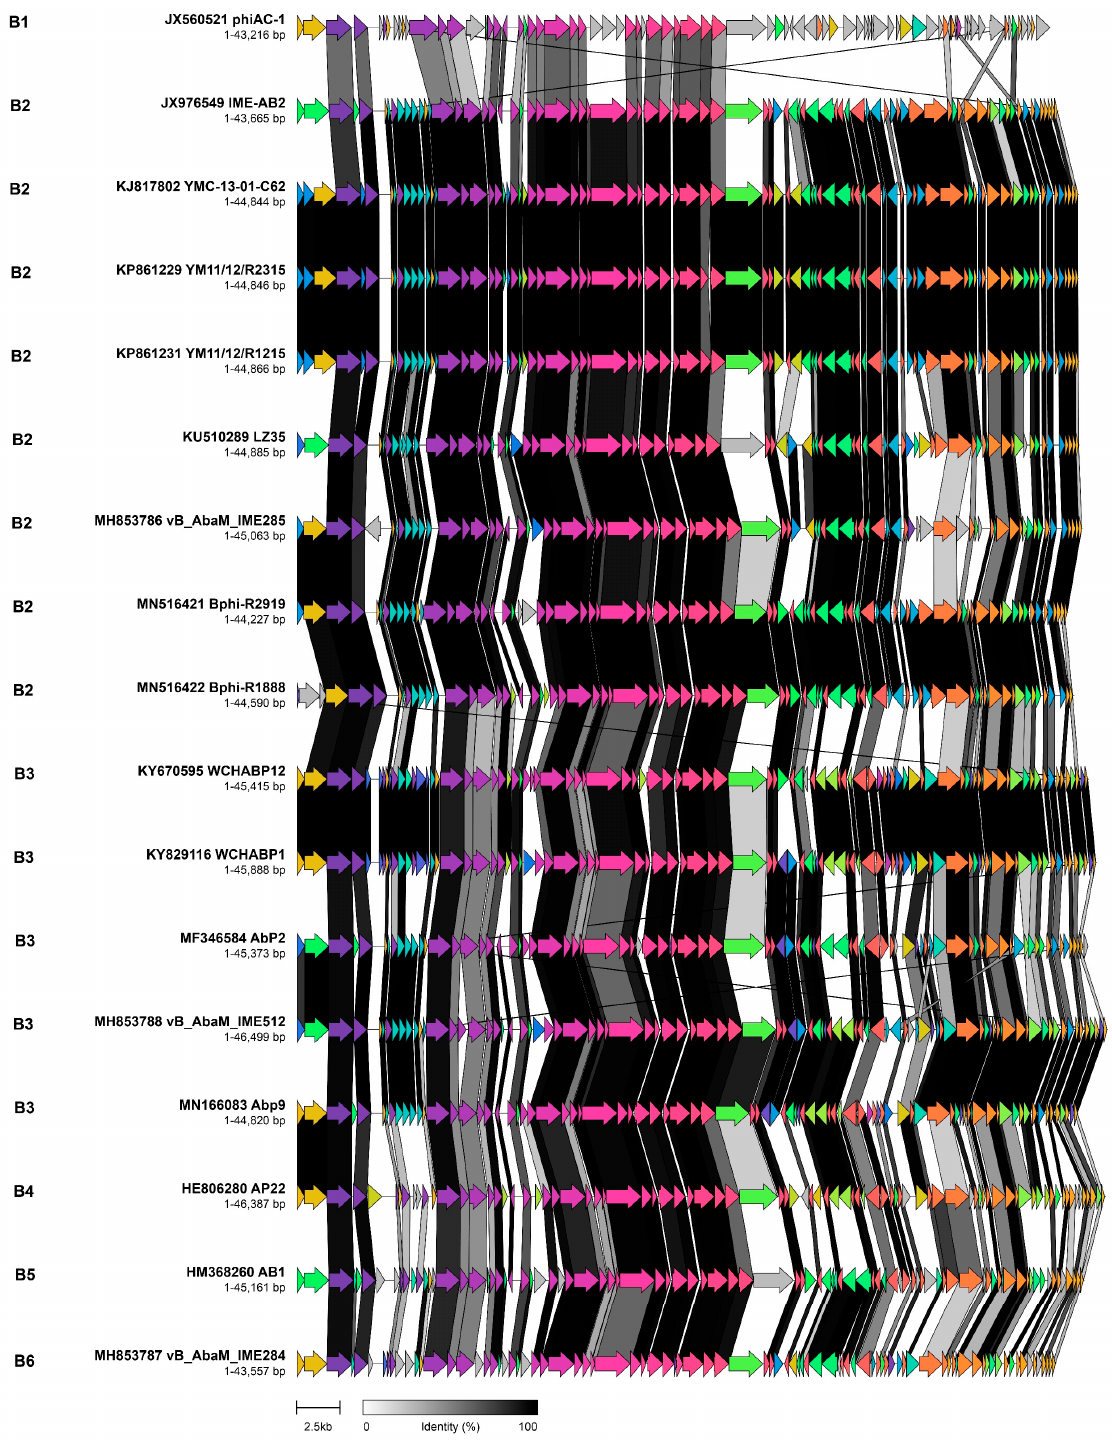
Figure 5. Comparative genome alignment of phages comprising sub-cluster B. Phage genomes are presented alongside their designated sub-cluster, accession number, name and genome length. Coding sequences are represented by arrows, coloured to reflect homologous groups identified by Clinker, and are linked by grey bars shaded to represent the percentage amino acid identity, as indicated in the